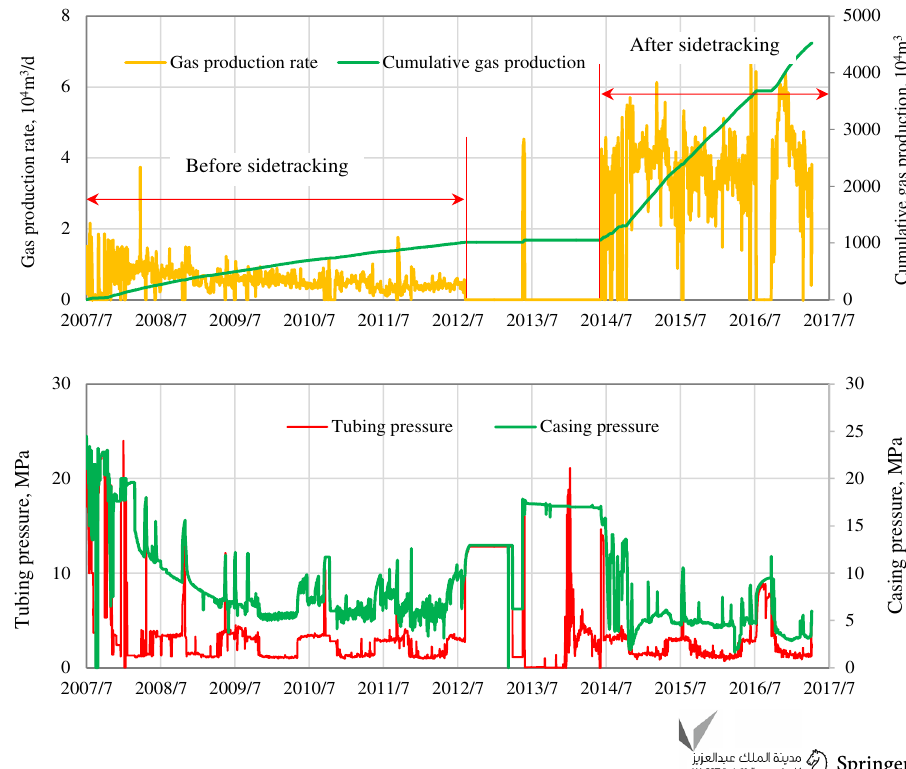
Fig. 11 Production curve of well Su